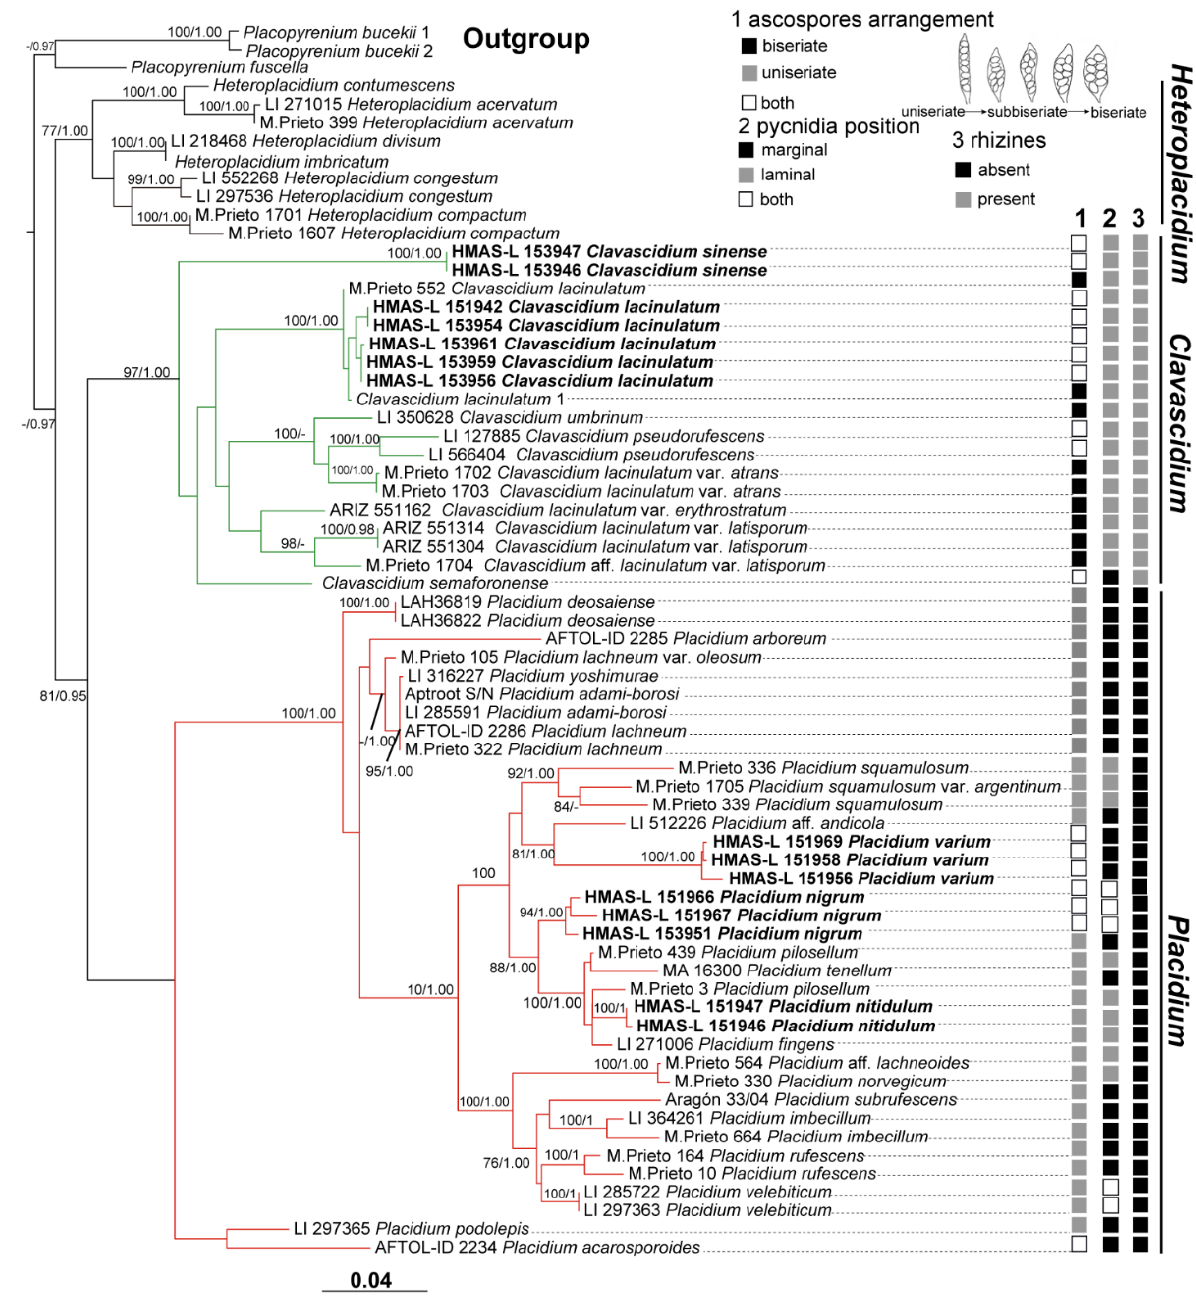
Figure 1. Collection sites. The detailed collection areas are marked in a solid red circle, and the cor- responding four provinces involved are marked with varying degrees of a gray color.